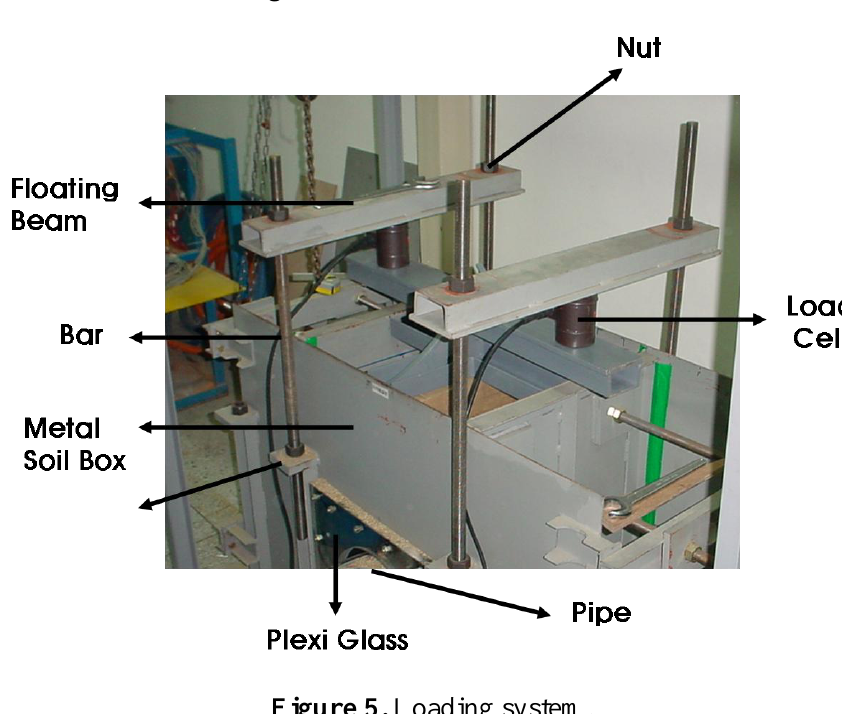
Figure 5. Loading